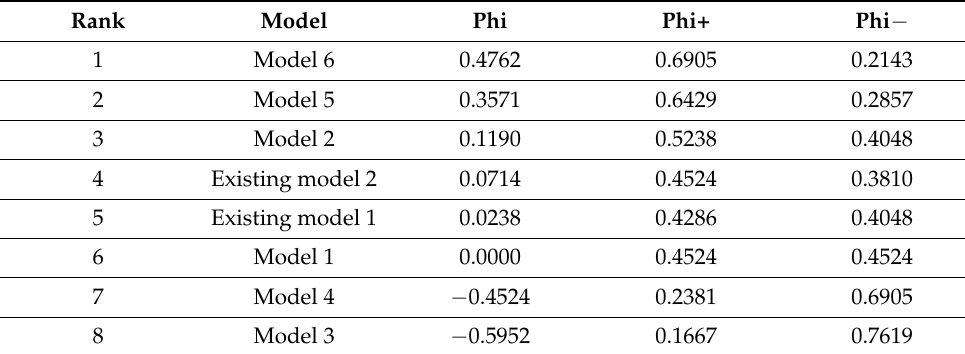
Table 12. MCDM results.